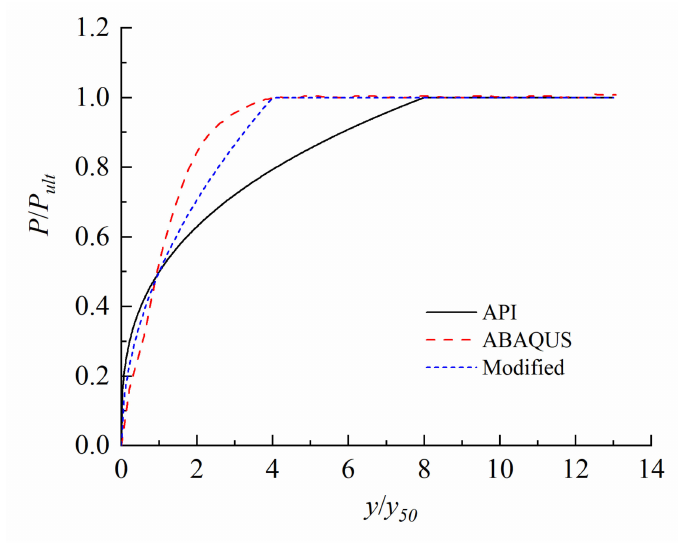
Figure 18. P / P ult - y / y 50